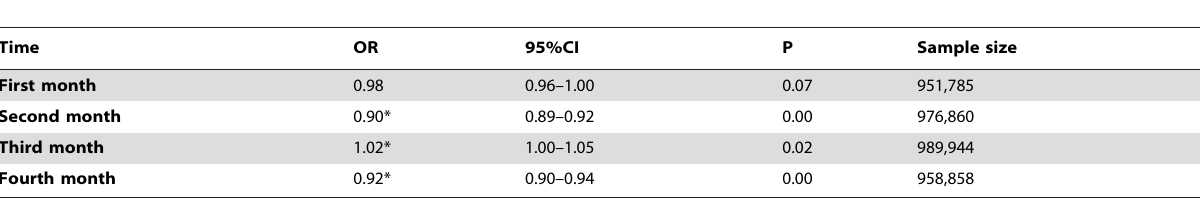
Table 5. Comparison of intervention effect in each month after